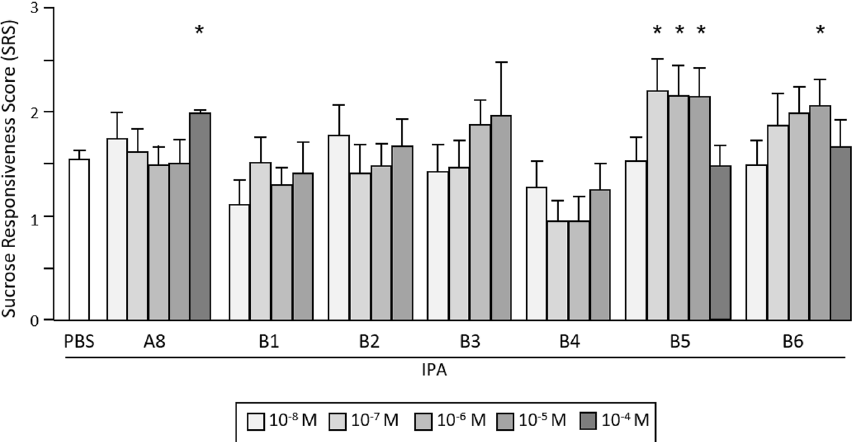
Figure 7. Compared effects of B-series molecules on sucrose responsiveness. Mean sucrose responsiveness score values in bees injected with PBS, A8, or either molecule of the B series (between 10 –8 and 10 –5 M), then exposed to IPA (2 replicates). Data from an additional experiment using injections of A8, B5 and B6 at 10 –4 M have been included. Treatment with B5 or B6 significantly improved sucrose responsiveness, with a greater efficiency than A8, particularly for B5. *: p < 0.05 (PBS: n = 186; B compounds: 28–41/group).